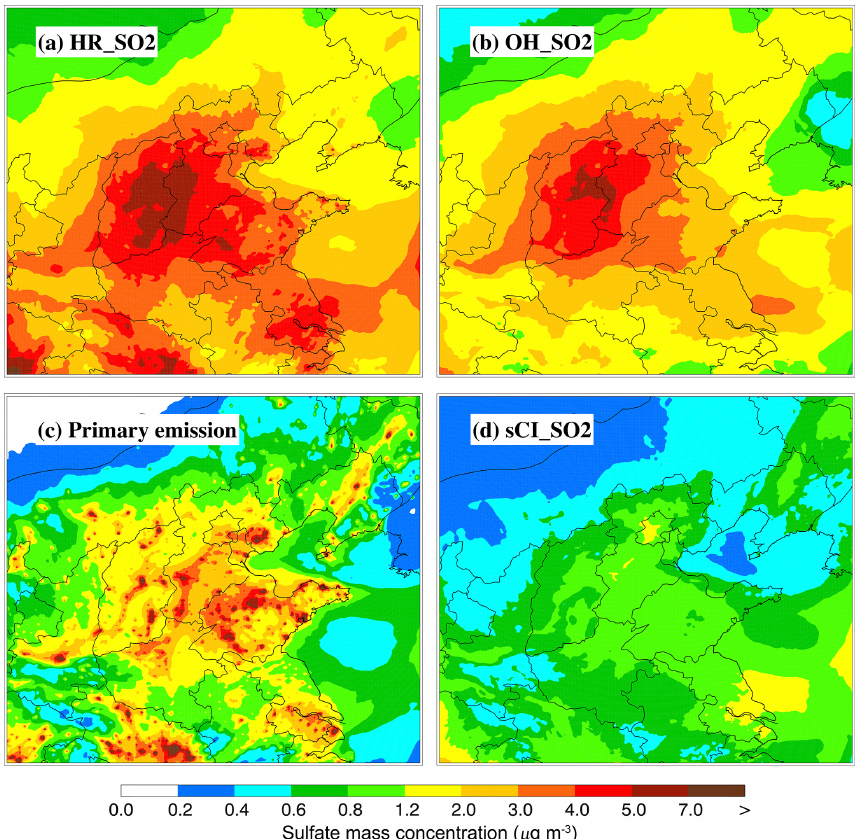
Figure 9. Spatial distributions of the average sulfate contributions of (a) HR_SO 2 , (b) OH_SO 2 , (c) primary emissions, and (d) sCI_SO 2 in BTH from 4 to 15 July 2015.